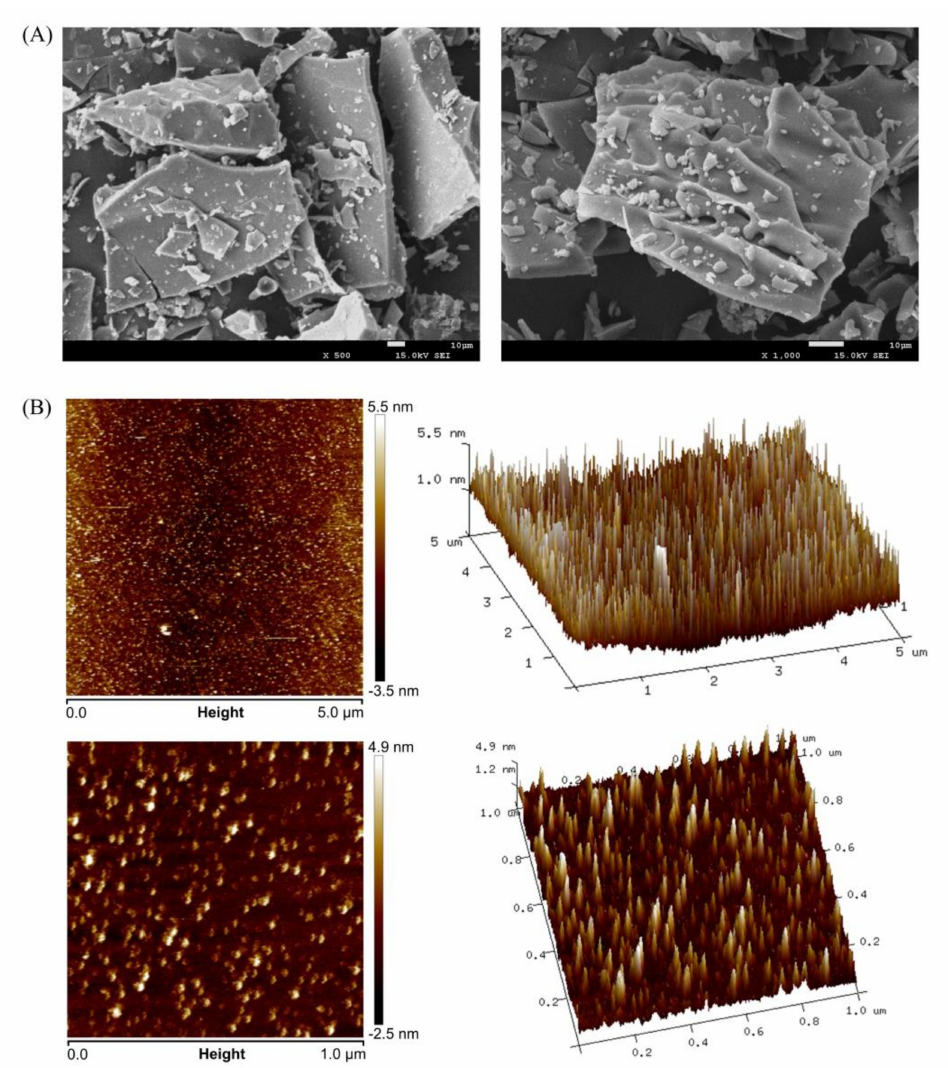
Figure 5. Morphological characteristics of TBs-10-30k. ( A ) Images magnified by scanning electron microscopy at 500 and 1000 times, respectively. ( B ) Planar images and corresponding three-dimensional images of TBs-10-30k obtained by atomic force microscopy. The scanning range is 5 × 5 µ m and 1 × 1 µ m,